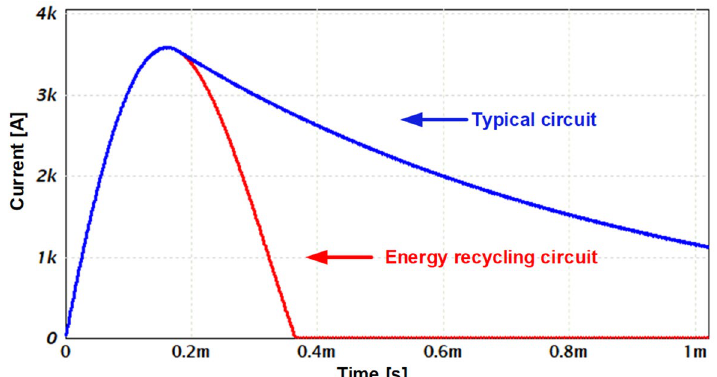
Figure 3. Comparison between the current pulses obtained from the typical circuit (blue curve) and the fast discharge circuit (red curve).